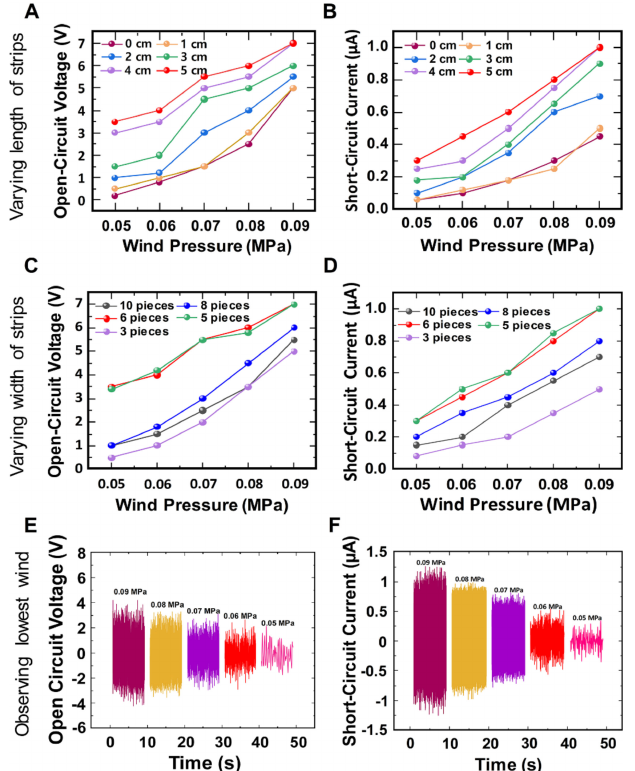
Figure 3. Examining the optimum length of the PTFE strips under di ff erent weak winds showing ( A ) Open-circuit voltage and ( B ) Short-circuit current; Examining the optimum width of the PTFE strips under di ff erent weak winds showing ( C ) Open-circuit voltage and ( D ) Short-circuit current ( E ) Open-circuit voltage and ( F ) Short-circuit current for observing the minimum wind